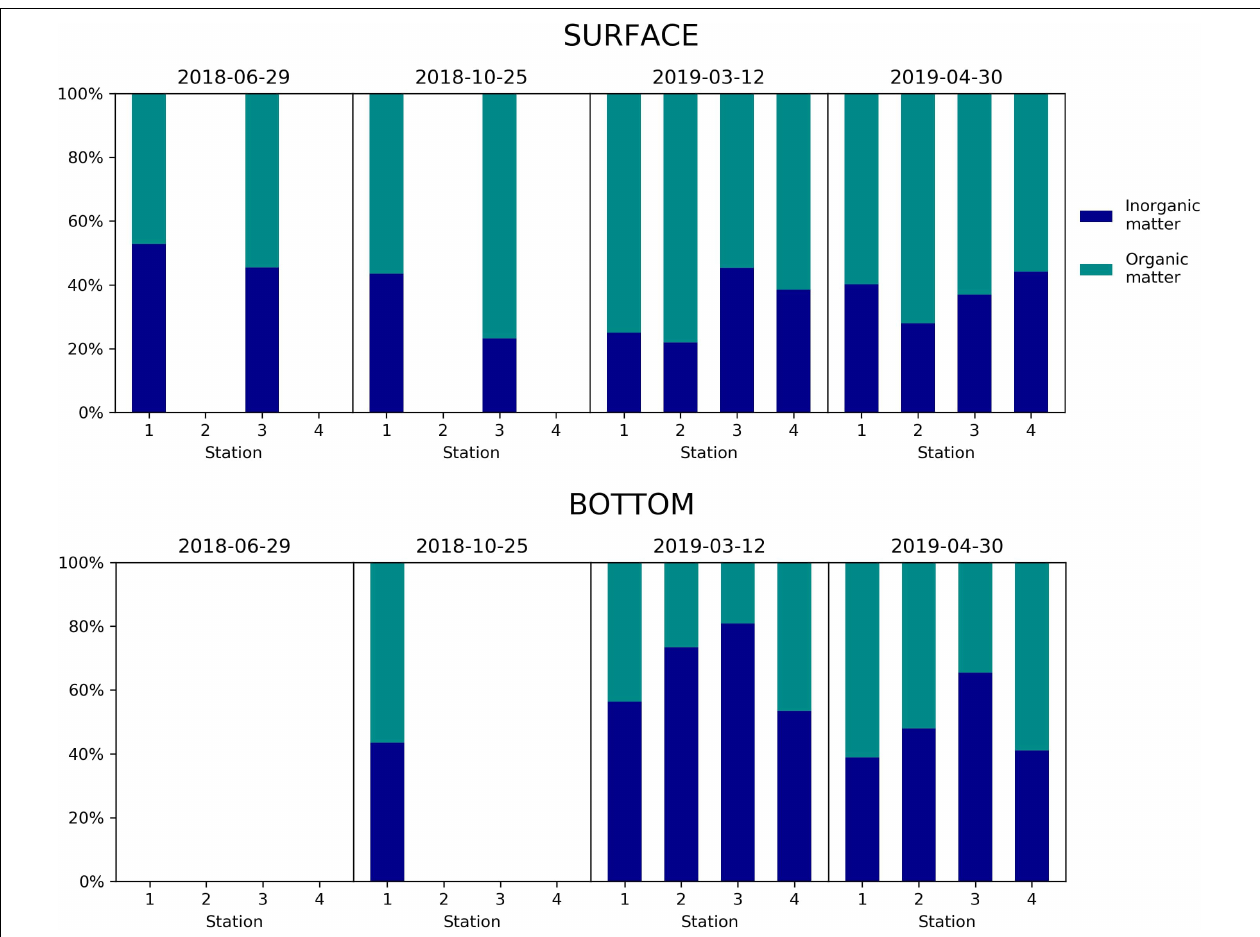
FIGURE 2 | Percentage of particulate inorganic and organic matter in surface (top) and bottom (down) samples on 2018-06-29, 2018-10-25, 2019-03-12, and 2019-04-30. In June 2018, only stations 1 and 3 were sampled on the surface. In October 2018, only stations 1 and 3 were sampled at the surface, and only Station 1 was sampled on the bottom.